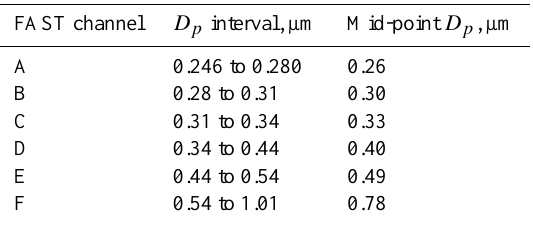
Table 1. FAST sensing diameter: ranges and mid-points.